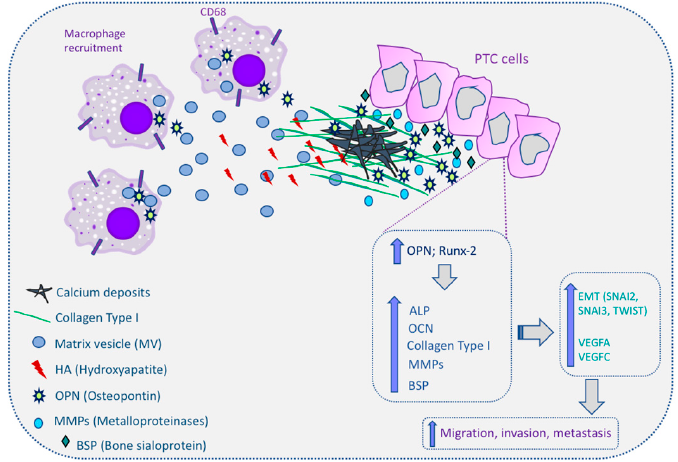
Figure 3. Molecular mechanism of calcification in papillary thyroid cancer (PTC) cells. Macrophages can be recruited to the PTC microenvironment and release matrix vesicles (MVs) to the extracellular matrix (ECM). MVs contain hydroxyapatite (HA), which initiates the calcification process. Osteopontin (OPN) and runt-related transcription factor-2 (Runx-2) are overexpressed in PTC cells and this increases the expression of alkaline phosphatase (ALP), osteocalcin (OCN), collagen type I, metalloproteinases (MMPs), and bone sialoprotein (BSP). All these molecules are involved in the induction of calcium deposits in the ECM, culminating in the calcification process in thyroid tissues, and also induce the expression of epithelial–mesenchymal transition genes (snail family transcriptional repressor (SNAI)2, SNAI3, and twist-related protein 1 (TWIST1)) and angiogenic factors (vascular endothelial growth factor (VEGF)A and VEGFC). Up arrows mean increase; The cells expressing CD68 correspond to